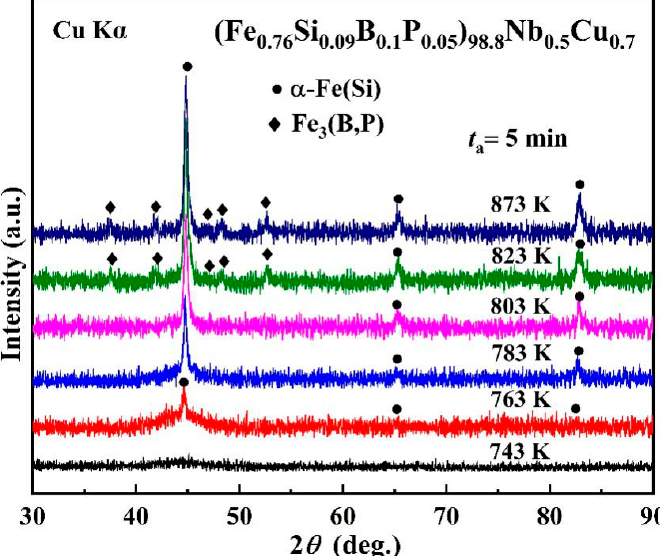
Figure 4. XRD patterns for the (Fe 0.76 Si 0.09 B 0.1 P 0.05 ) 98.8 Nb 0.5 Cu 0.7 ribbons after being annealed under several temperatures for 5 min, respectively.